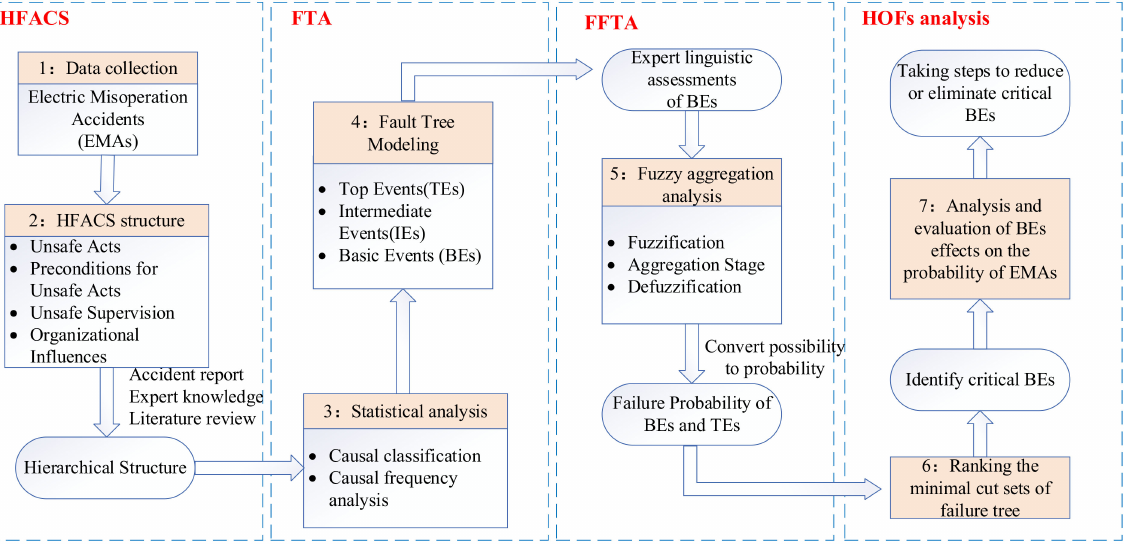
Figure 1. The framework of the